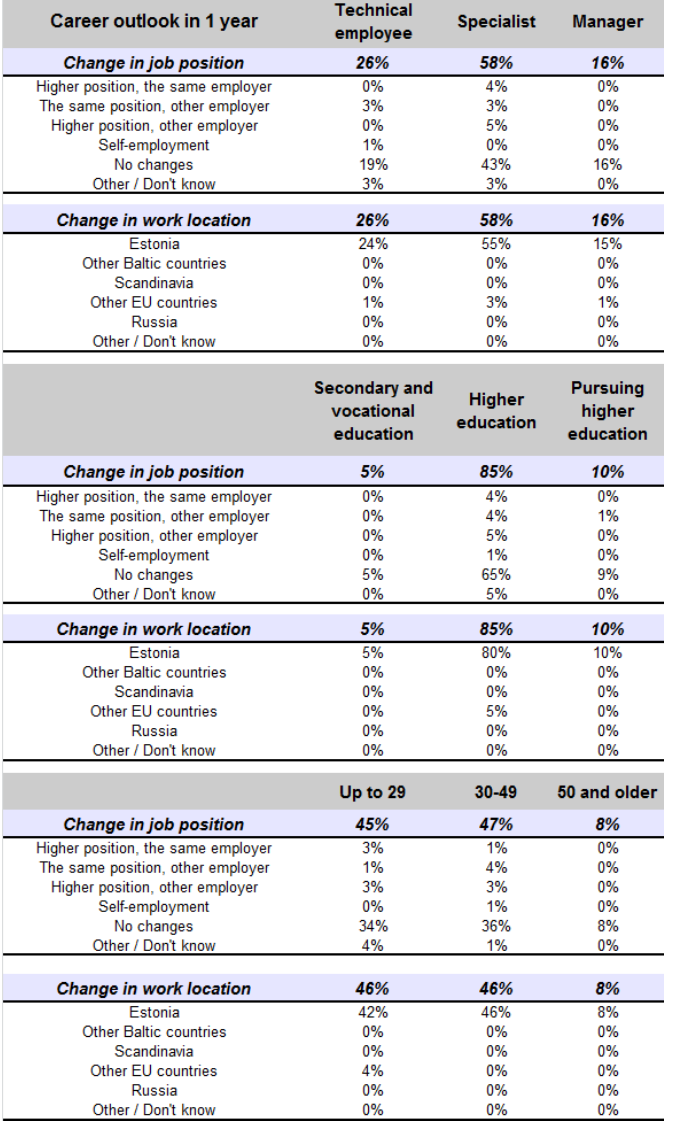
Table 24 - Professional career, short-term